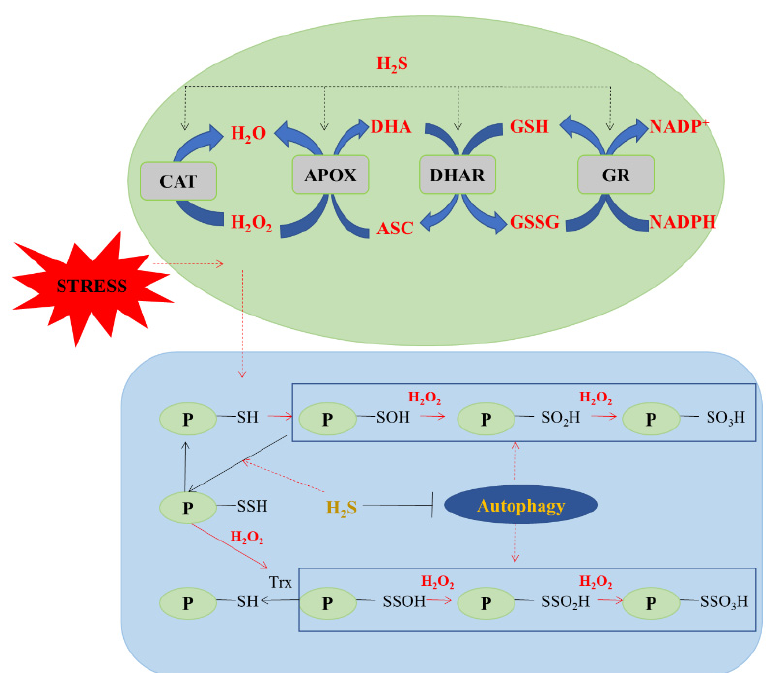
Figure 3. Diagrammatic description of inter-relationship between H 2 S and oxidative stress signaling. Abiotic stresses induce ROS and H 2 S, which metabolizes the catalytic action of various antioxidant enzymes such as SOD, POD, CAT, APOX, DHAR, GST, GR, etc. and reduce their substrates ascorbate, glutathione and NADPH to lower the ROS generation through metabolizing H 2 O 2 . After the encounter of oxidative stress, protein cysteine thiols are also oxidized by H 2 O 2 into sulfenic acid, which are further hyperoxidised into sulfinic acid and sulfonic acid. H 2 S and sulfenic acids further combine to form persulfidated proteins and most importantly they can also reduce back to thiols through thioredoxin enzyme that potentially reduce the disulfide bonds. Sidewise, persulfidated proteins in combination with ROS also give rise to perthiosulfinic and perthiosulfonic acids that might get reduced very easily by thioredoxins to generate thiols. H 2 S also regulate autophagy that could denature oxidized proteins and maintain stability of proteins. Dual role of H 2 S aids plants to operate their proteins efficiently against ROS-generated oxidative stress with consumption of energy through de novo synthesis of proteins for growth, development, and defense mechanisms.